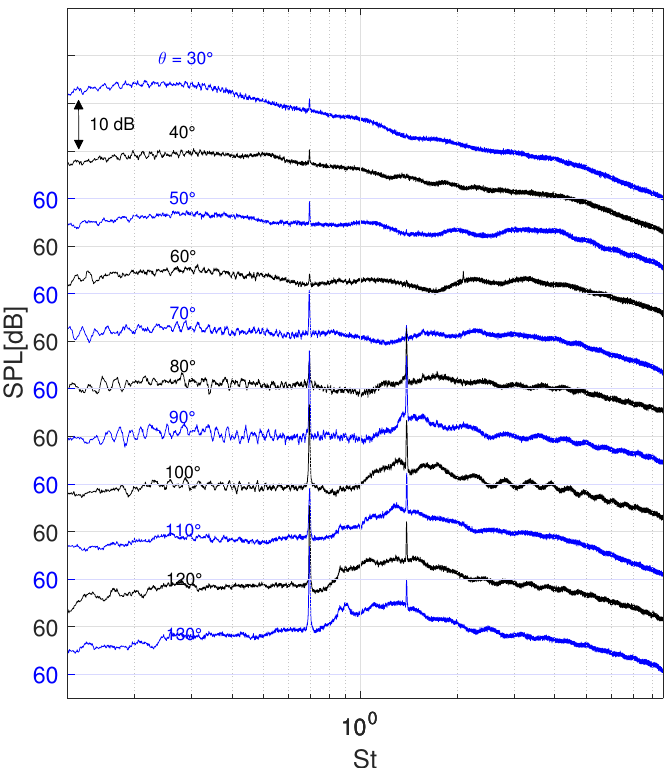
Figure 29. SPL (reference 2 × 10 − 5 Pa) at r / D 2 = 40 for FNPR = 2.450 ( M j = 1.21 ) and CNPR = 1.675 ( M = 0.89 ) at all the measured angles, nozzle diameter D j